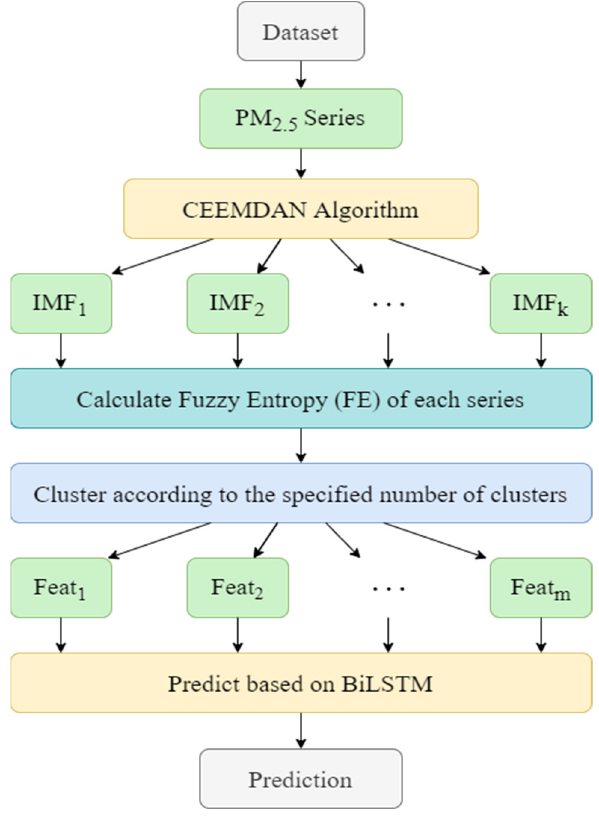
Figure 2. CEEMDAN-FE-BiLSTM model flow